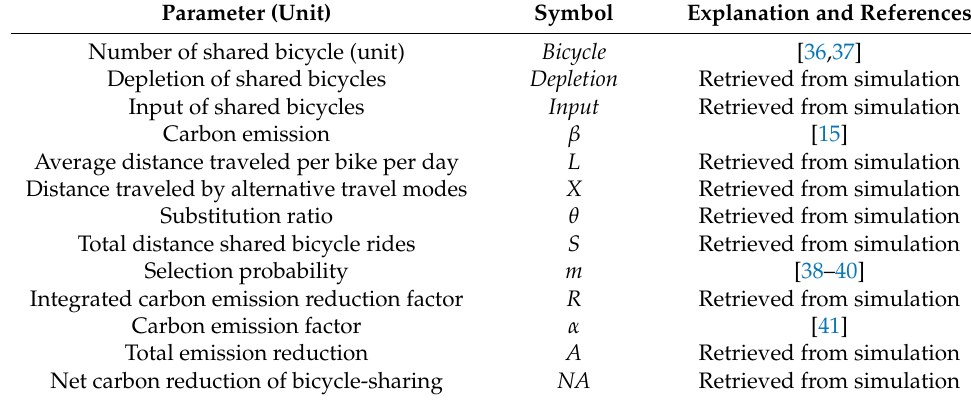
Figure 1. The structure of the module. Table 1. Variable description.